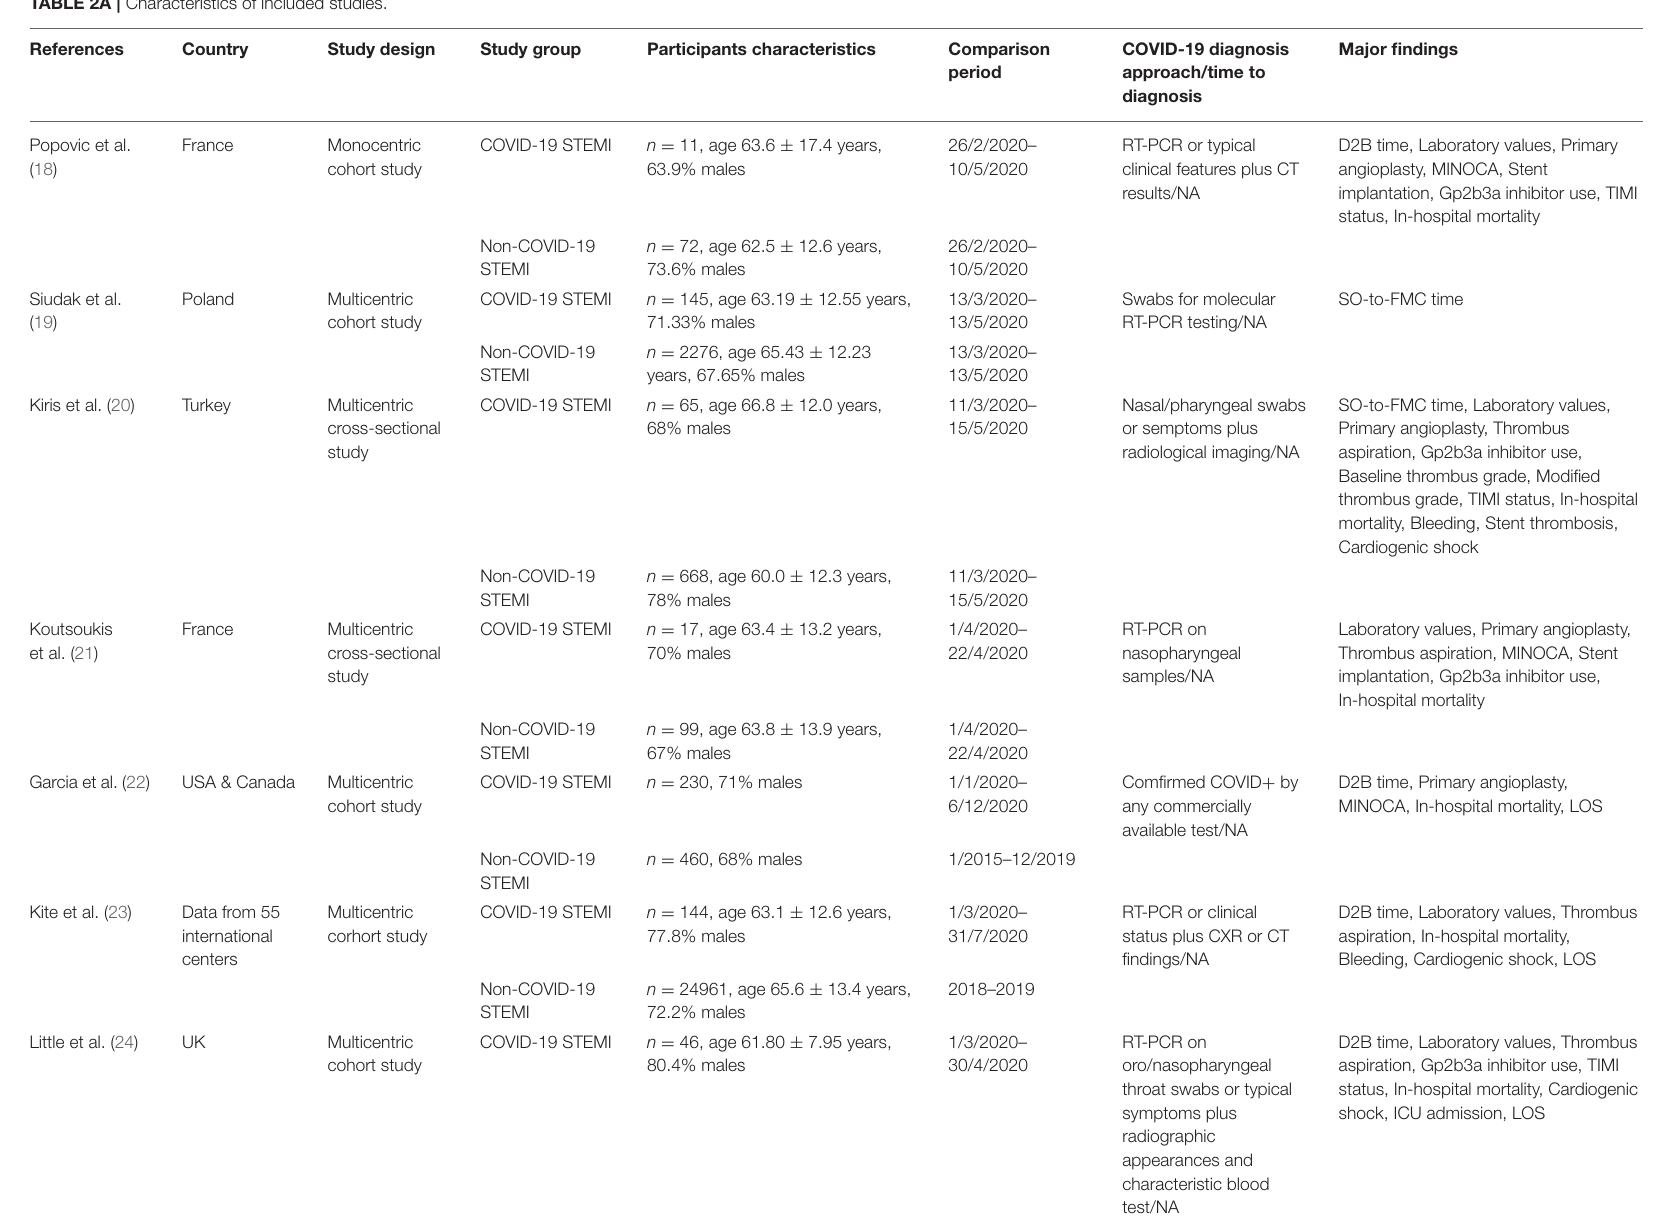
TABLE 2A | Characteristics of included